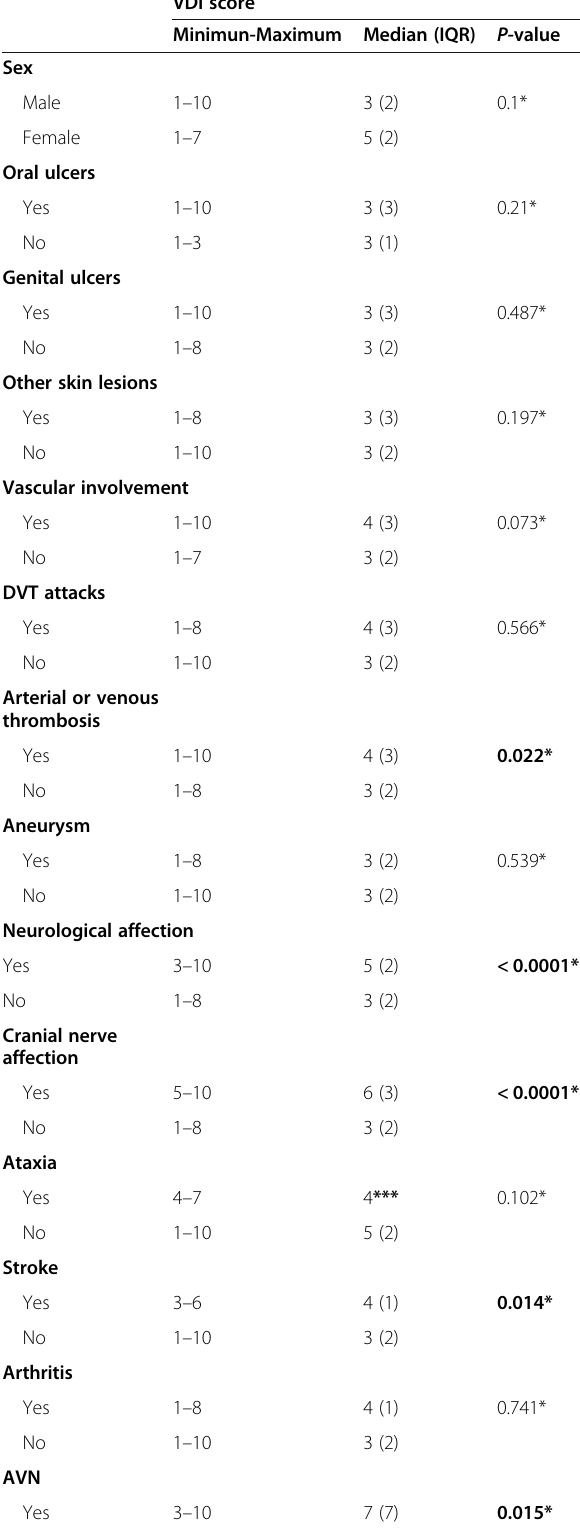
Table 3 Comparison of Vasculitis Damage Index (VDI) with respect to demographic and clinical manifestations